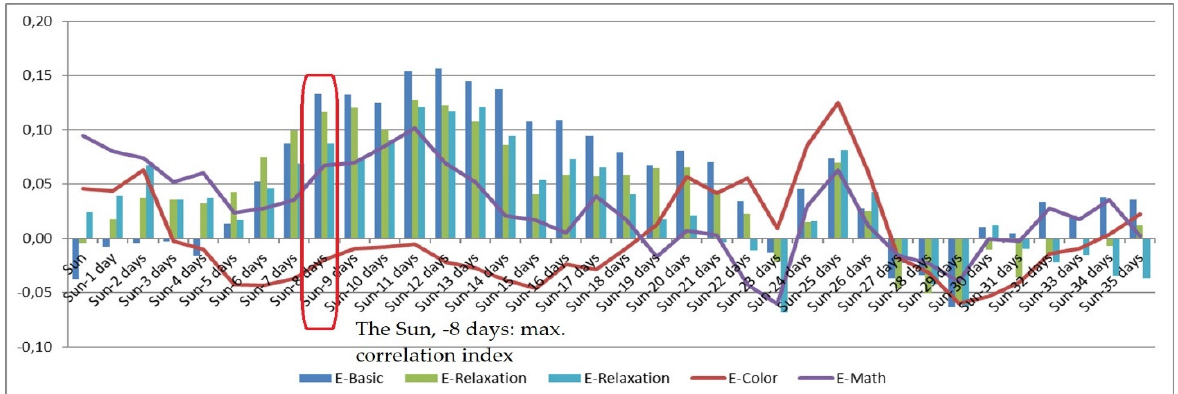
Figure 5. The correlation dependency of the psychophysiological parameter B (BVP HF % power mean) on the intensity of solar activity.